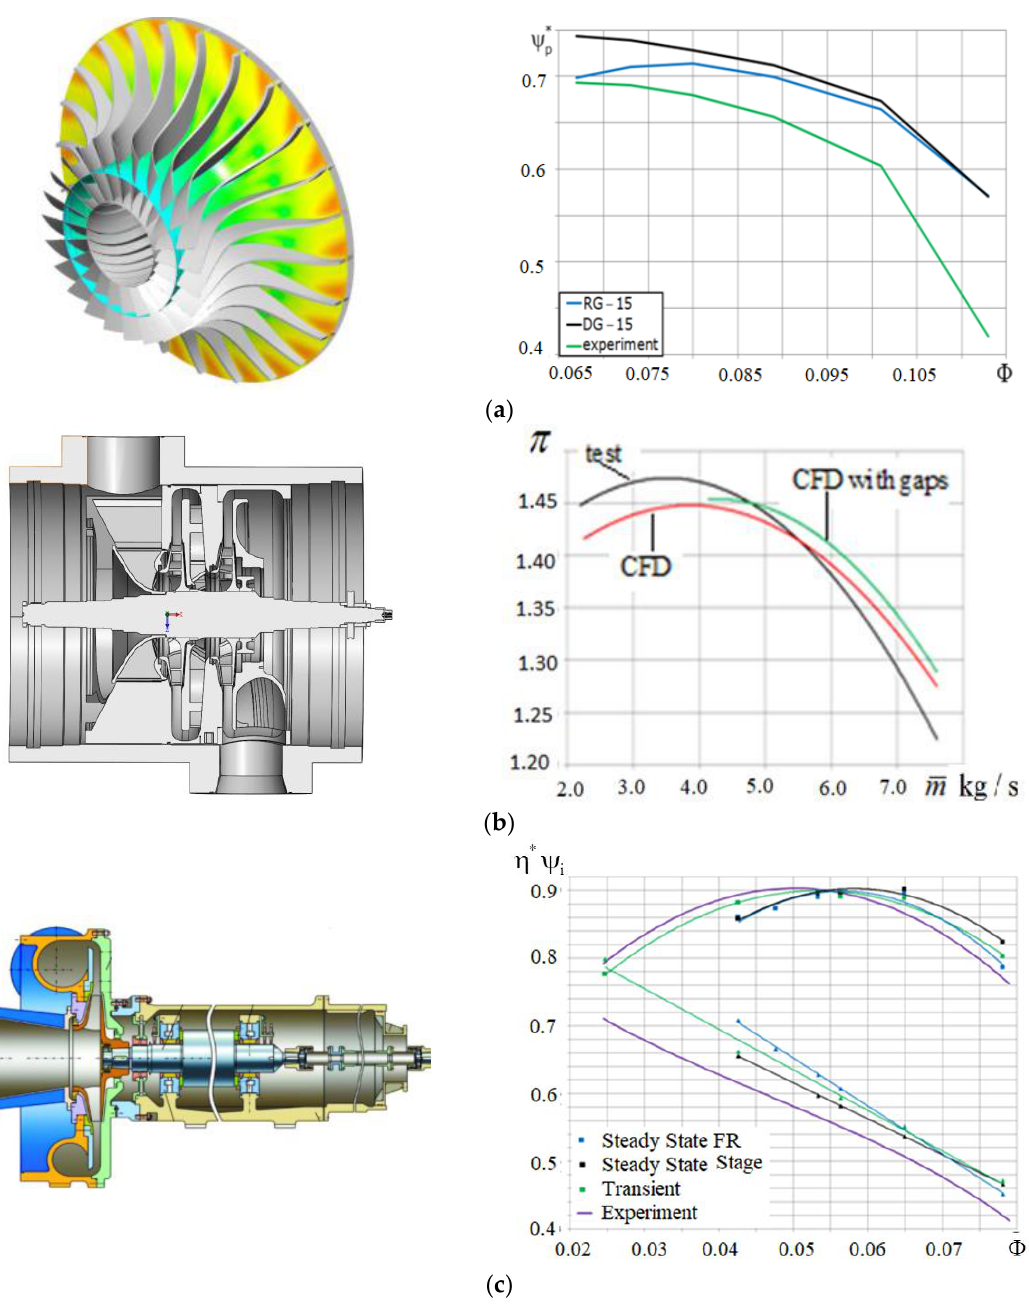
Figure 2. (a ) 3-D impeller and its polytropic coefficient characteristics (rare and dense grids, sector 150) [8]; ( b ) Two-stage compressor 16 MW pipeline compressor unit and its pressure